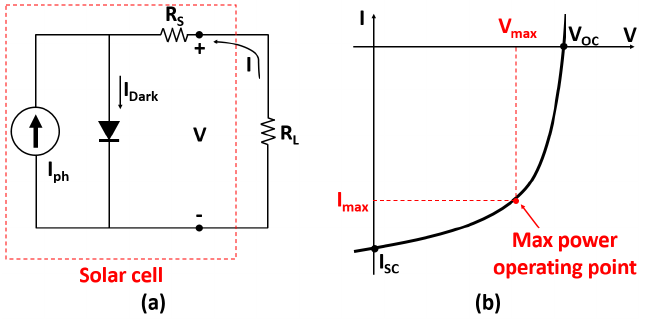
Figure 2. ( a ) Equivalent circuit of the solar cell. ( b ) Qualitative plot of the I–V characteristics of the solar cell.